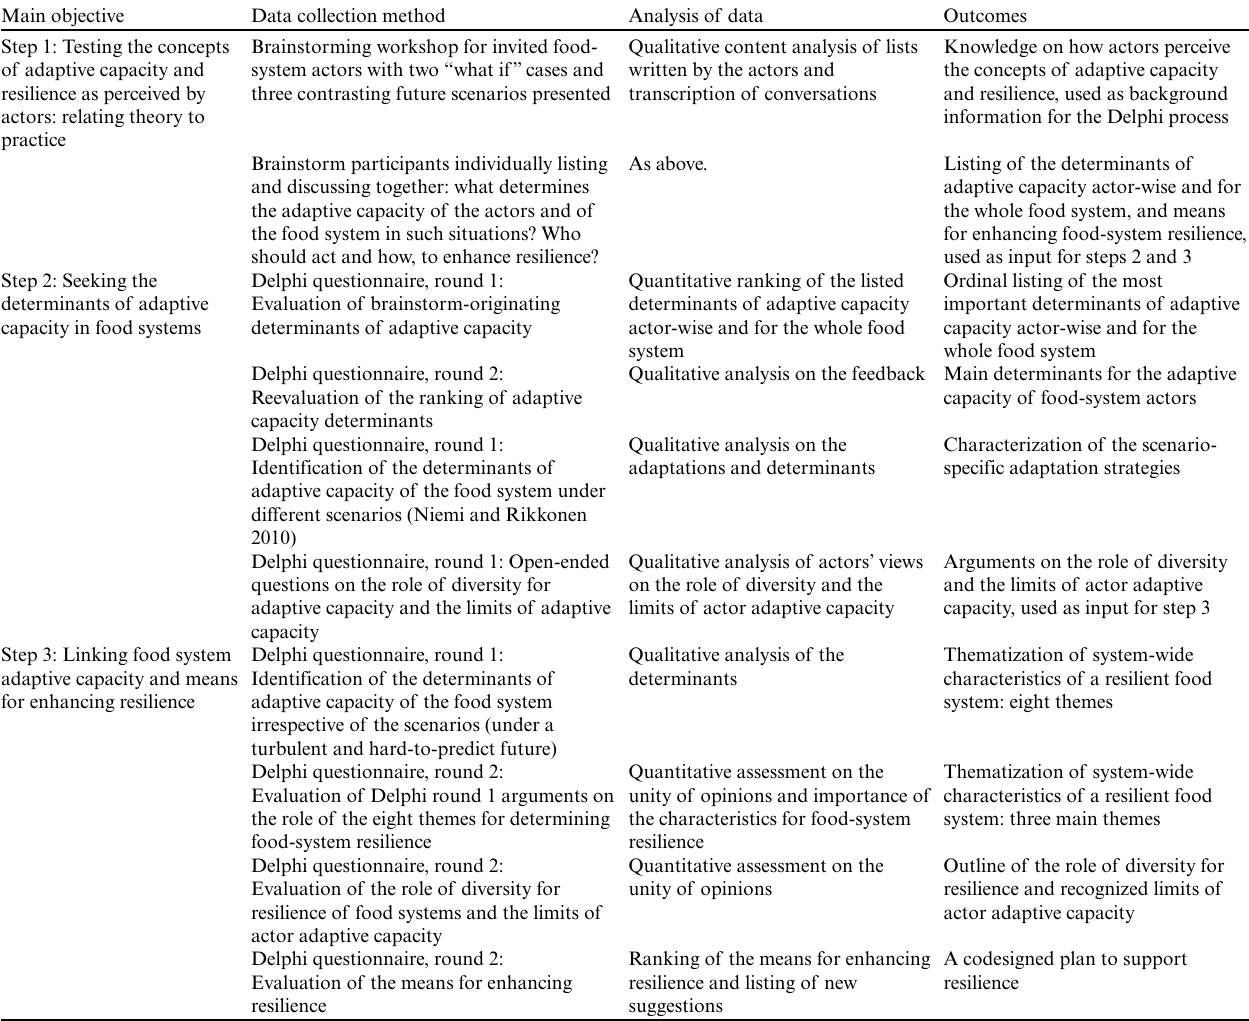
Table 1 . Outline of the